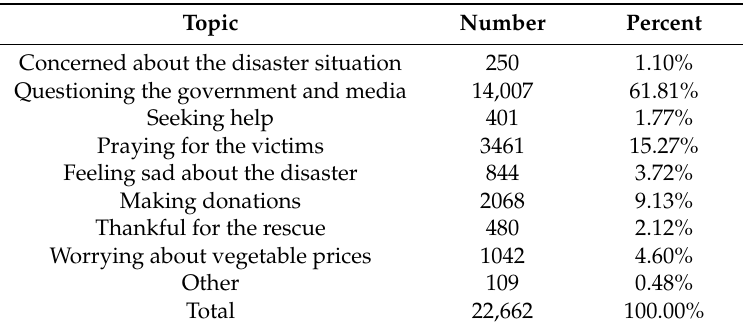
Table 2. Classification statistics of nine sentiments.